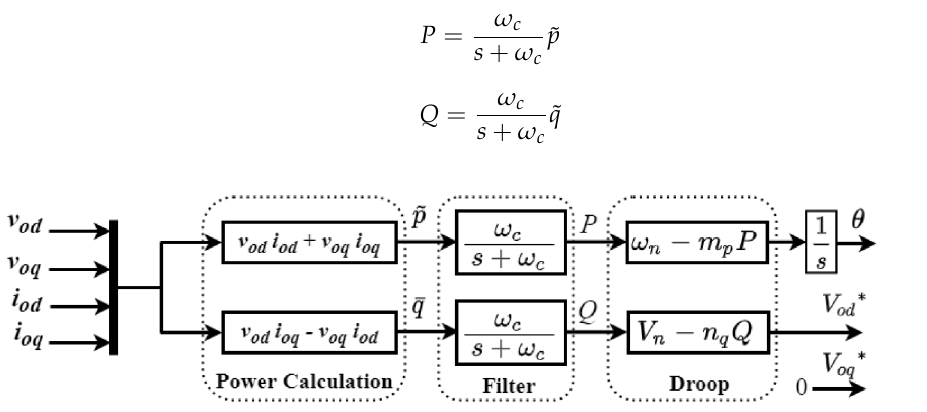
Figure 2. External power controller diagram of DG inverter